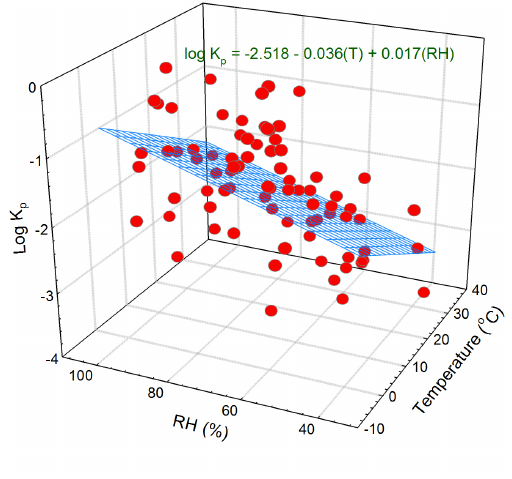
Figure 4. The gas-particle partitioning coefficient, K p , related to atmospheric temperature and relative humidity (RH) ( n =